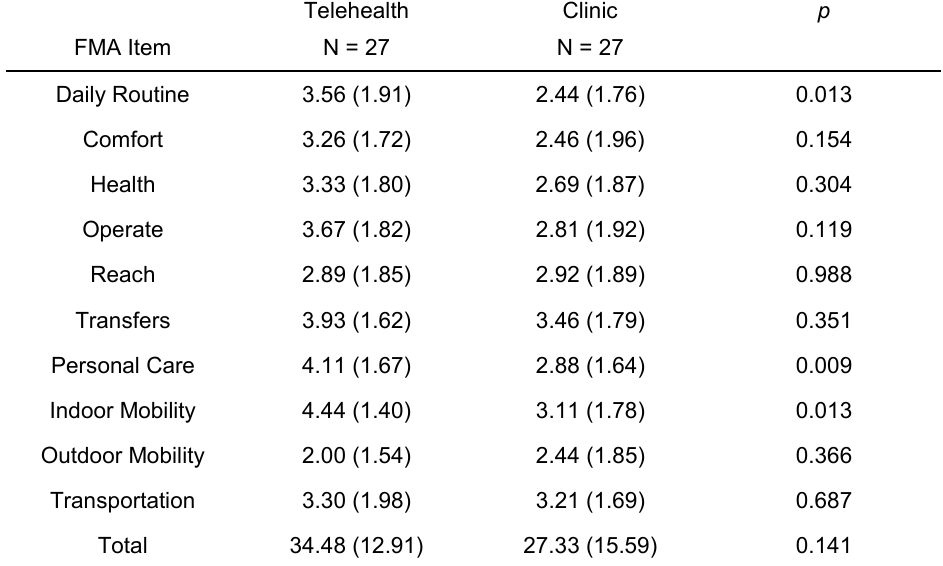
Table 3 shows results of comparing T2 FMA scores between the two groups. One participant marked ‘Does Not Apply’ for one individual FMA item (0.2% of responses). The FMA score for transfers was significantly higher in the telehealth group than the clinic group, but no other FMA scores were significantly